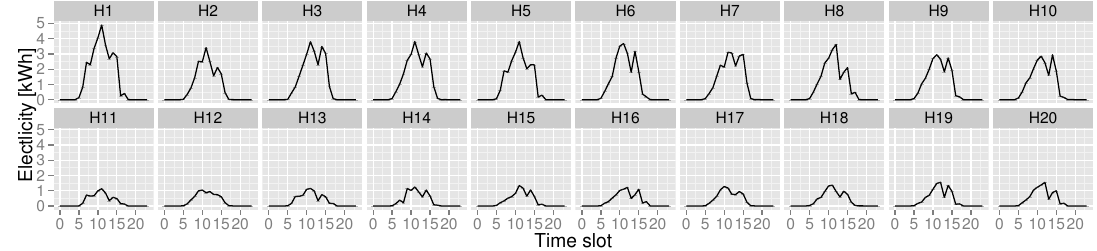
Figure 2. Electric energy generation profiles used in the experiment. The profiles are set to l t − ,max They were obtained from 20 prosumers’ photovoltaic (PV) cells in Higashi Ohmi city, Japan